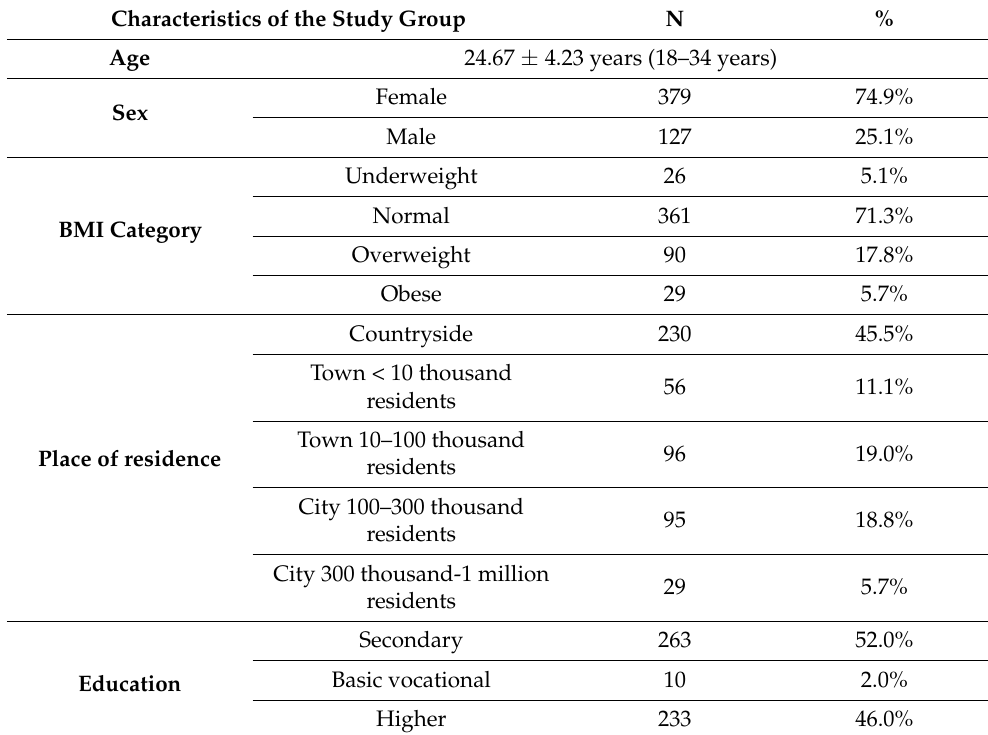
Table 1. Characteristics of the study